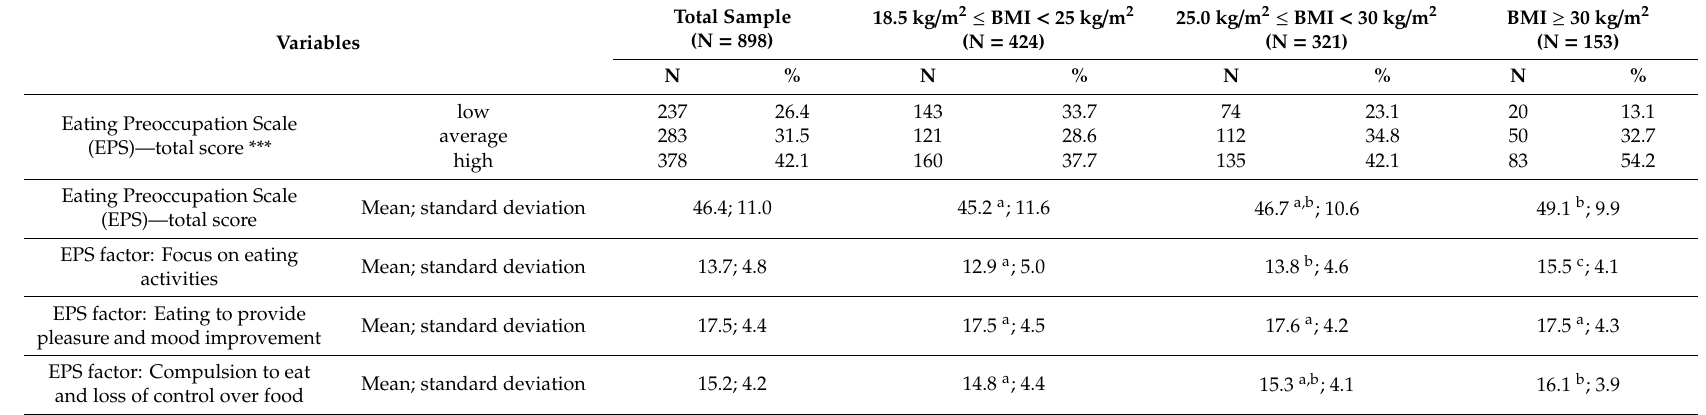
Table 4. Eating addiction in the study